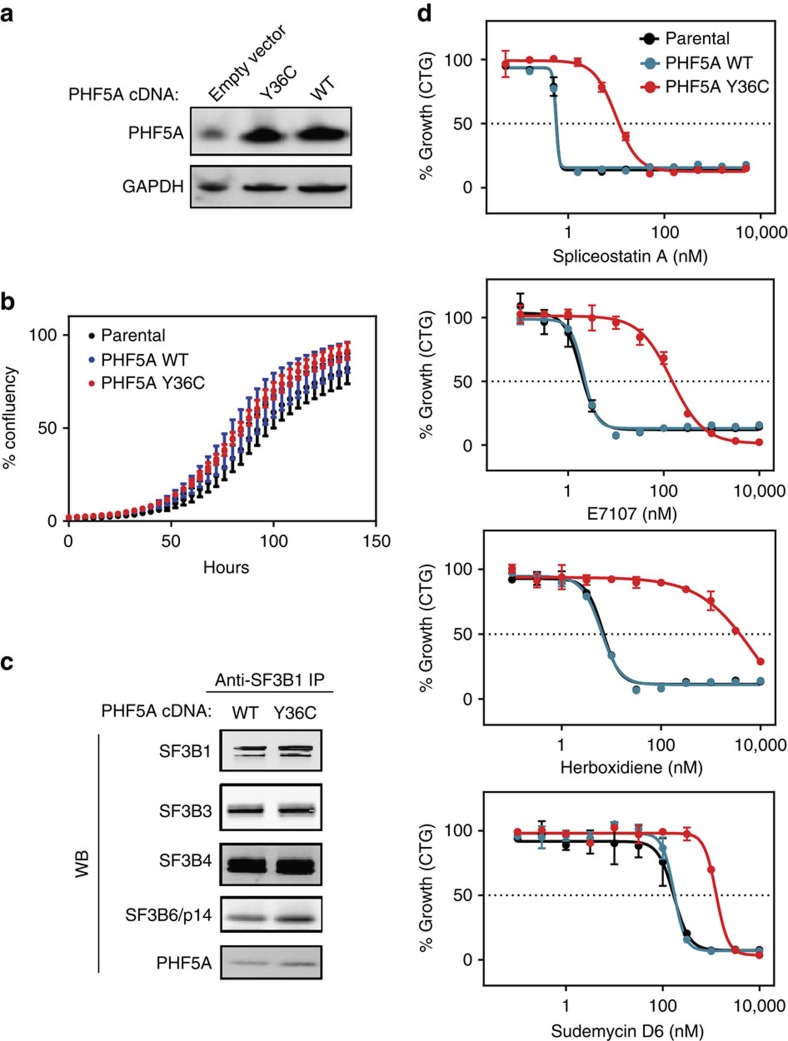
PHF5A-Y36C does not affect basal cellular functions but confers resistance to splicing modulators.(a) Western blot analysis of PHF5A levels in parental, PHF5A WT-expressing and PHF5A Y36C-expressing HCT116 cells. GAPDH is shown as a loading control. (b) Proliferation of parental, WT PHF5A-expressing or Y36C PHF5A-expressing HCT116 cells as measured by the Incucyte imaging system. X axis indicates hours post seeding, and y axis indicates percent of confluency. Error bar indicates s.d., n=5. (c) Western blot analysis of indicated SF3b complex protein levels following anti-SF3B1 pull-down from nuclear extracts containing WT or Y36C PHF5A. (d) Seventy-two hours growth inhibition profiling (CellTiter-Glo cellular viability assay) of parental, PHF5A WT-expressing and PHF5A Y36C-expressing HCT116 cells in response to indicated splicing modulators. Error bar indicates s.d., n=2.